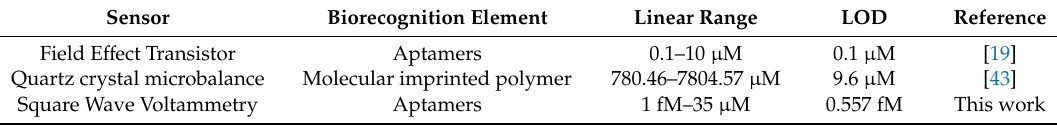
Table 1. Comparison of the sensitivity of the developed biosensors for the detection of